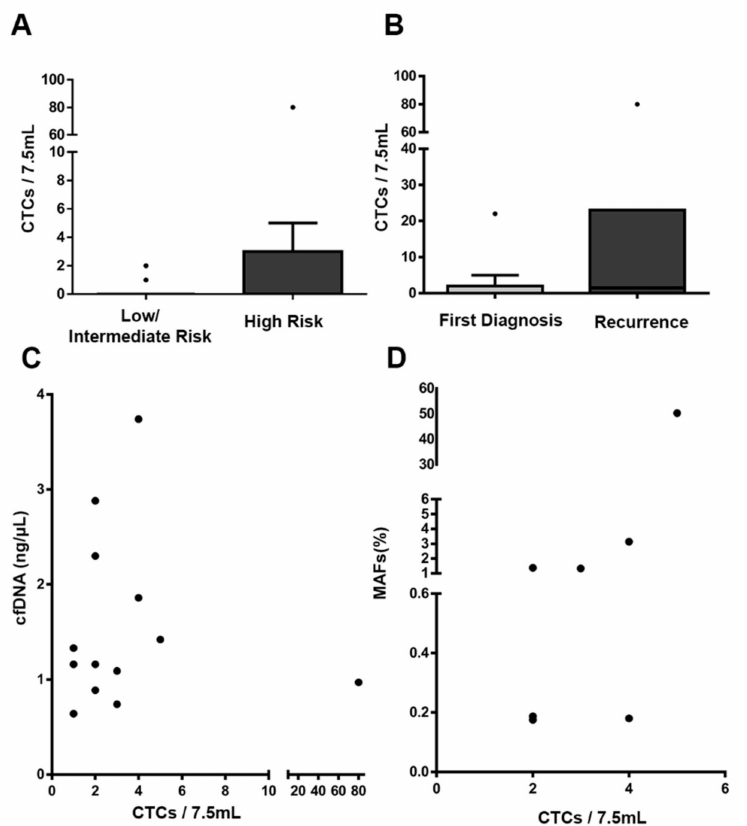
Figure 4. CTC enumeration with the CellSearch system. ( A – B ) CTC levels according to the risk of recurrence and the disease status at sample collection (first diagnosis versus recurrent disease). ( C ) Correlation between cfDNA concentration and CTC count. ( D ) Correlation between ctDNA levels (MAFs) and CTC count; n = 33 patients for ctDNA and CTC